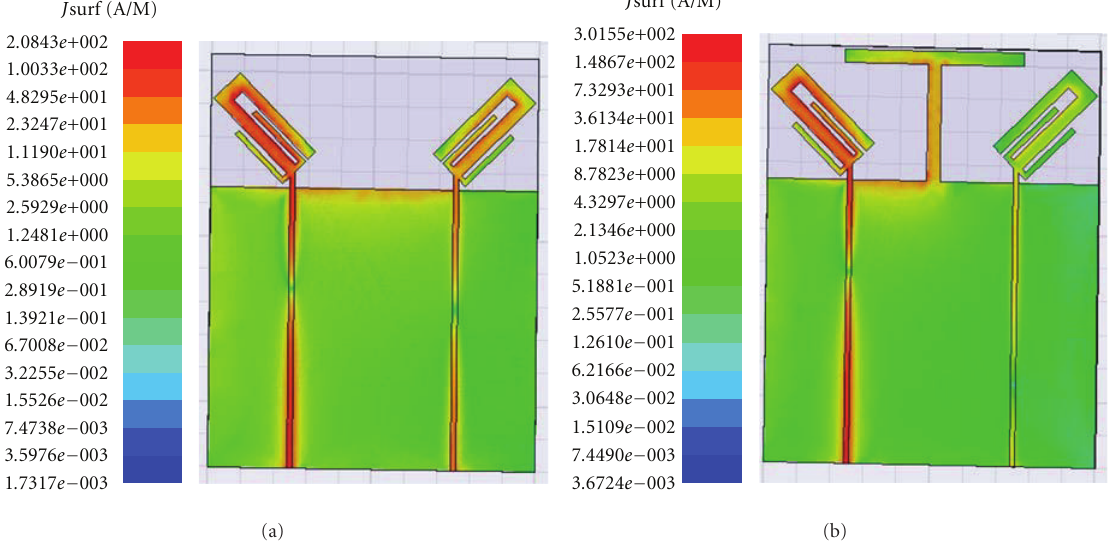
Figure 13: Simulated surface current distribution at 0.9GHz. (a) Without the T-shaped branch. (b) With the T-shaped branch.